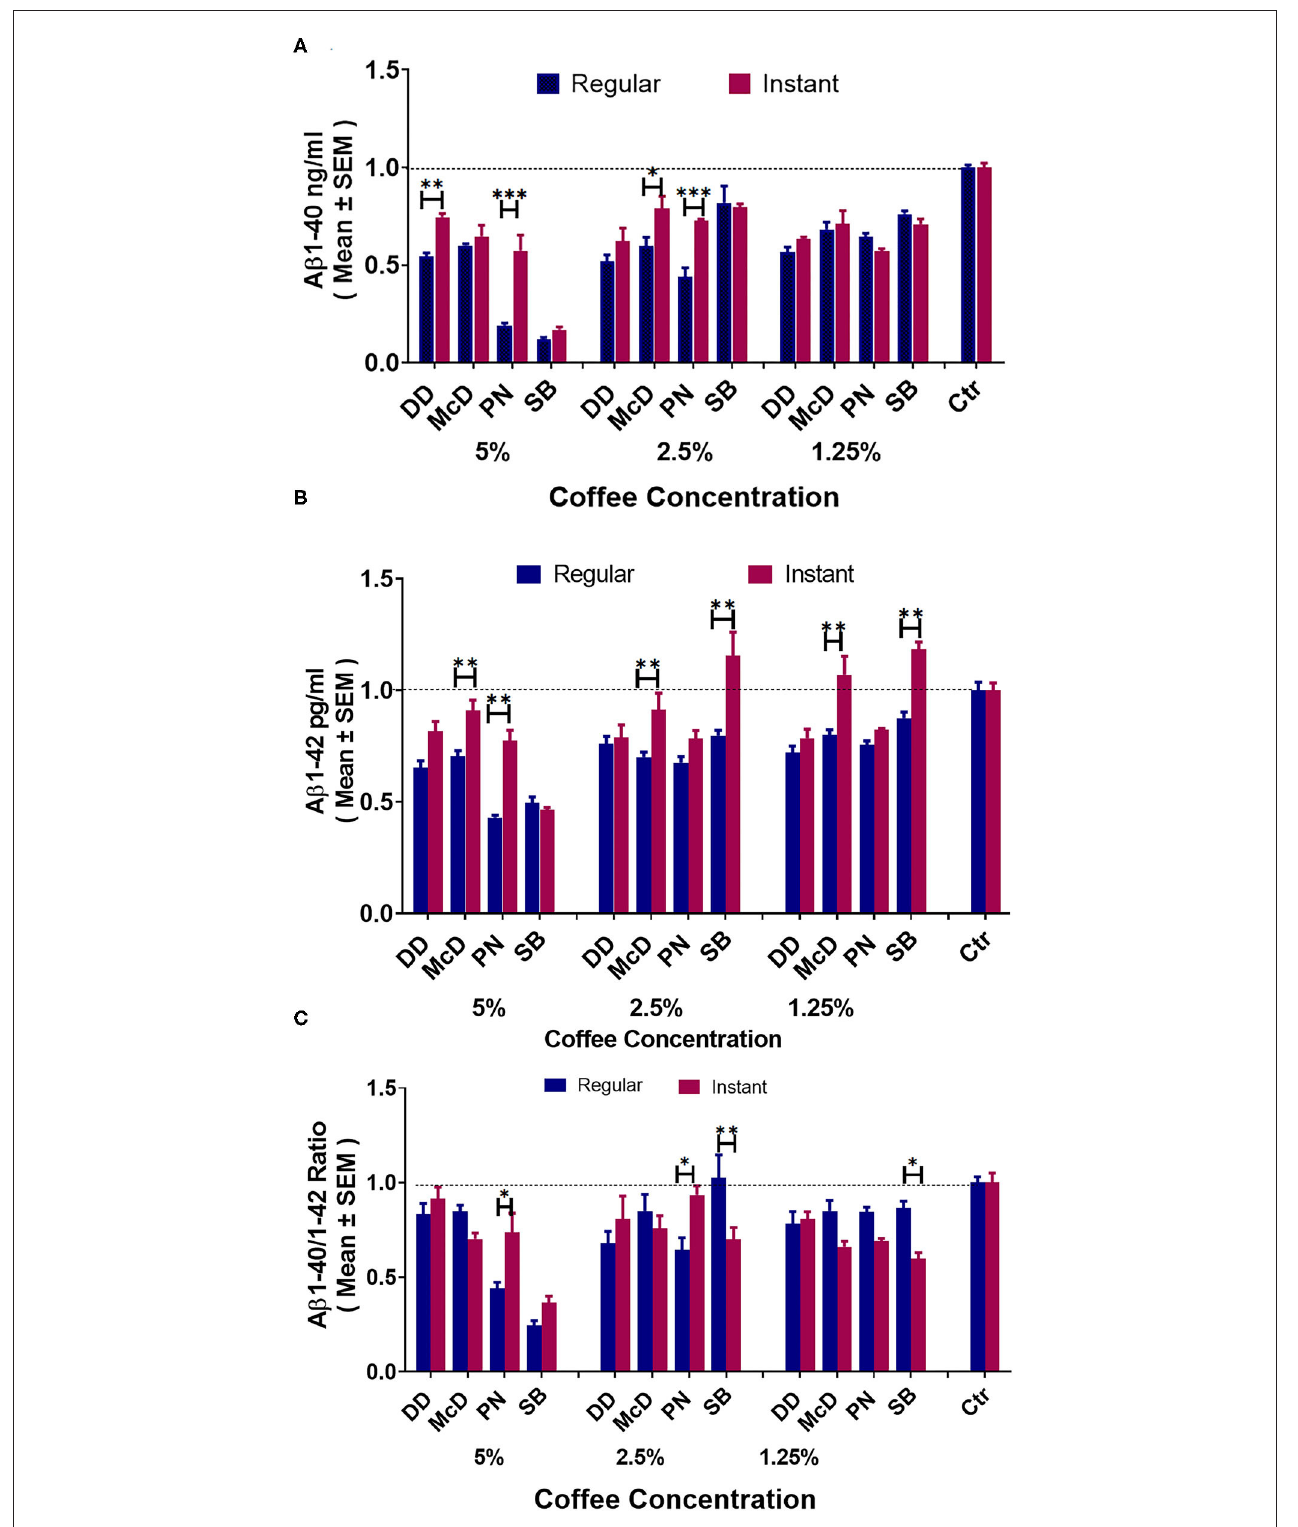
FIGURE 5 | ELISA results of A β 1-40 (A) , A β 1-42 (B) , and A β 40-42 ratio (C) levels in N2a/APPswe cells treated with different commercial coffees vs. their respective instant coffees at different concentrations ( N = 4). * P < 0.05, ** P < 0.01, and *** P < 0.001.